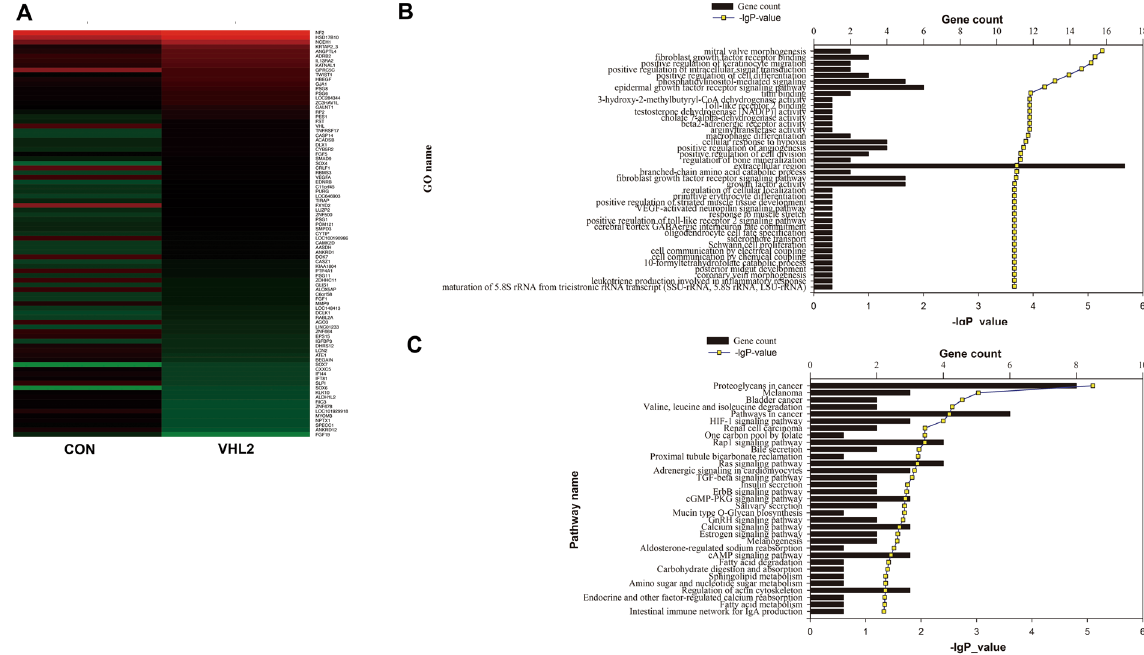
Figure 4. The difference of microarray gene expression profile between VHL-knockdown HUVEC cells and control group. The heat map ( A ) demonstrated the up-regulated and down-regulated genes in VHL-knockdown HUVEC cells compared to control group. The up-regulated genes were shown in red, while the down-regulated genes were shown in green. These up-regulated genes did not contain the specific mesodermal markers, such as SCl, brachyury and CD41. The Gene ontology ( B ) and KEGG pathway analysis ( C ) were used to demonstrate significantly changed pathways. The vertical axis is GO terms (up) and pathway category (down), and the horizontal axis is the gene count. P < 0.005 is used as a threshold to select significant GO categories, while P < 0.05 is used as thresholds to select significant KEGG pathway